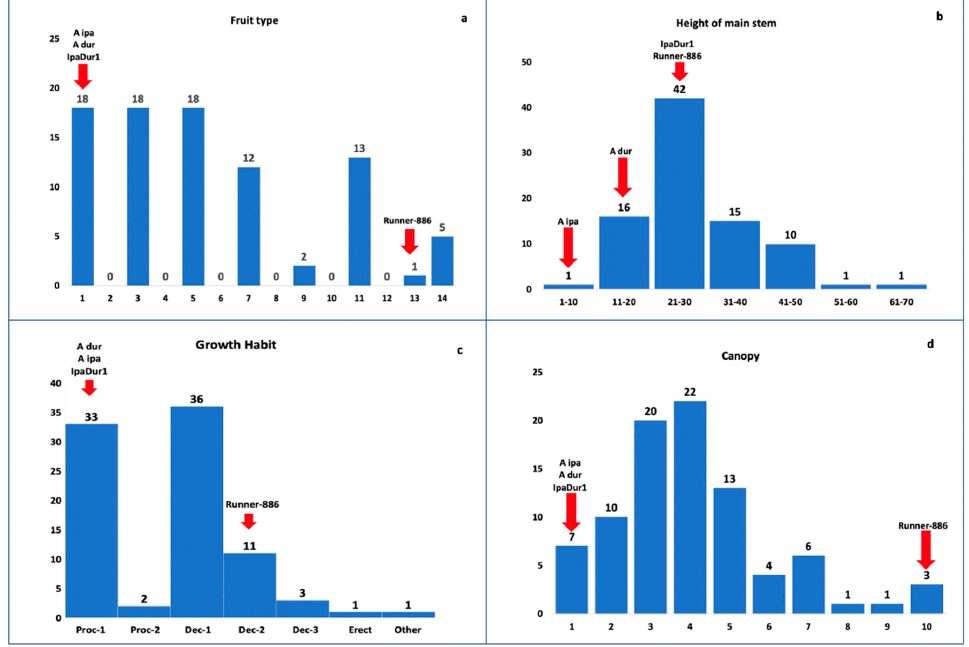
Figure 3. Distribution frequency for agronomic traits observed in the interspecific RIL population ‘Runner IAC 886’ x IpaDur1. ( a ) fruit type; ( b ) height of main stem; ( c ) growth habit; and, ( d ) canopy.